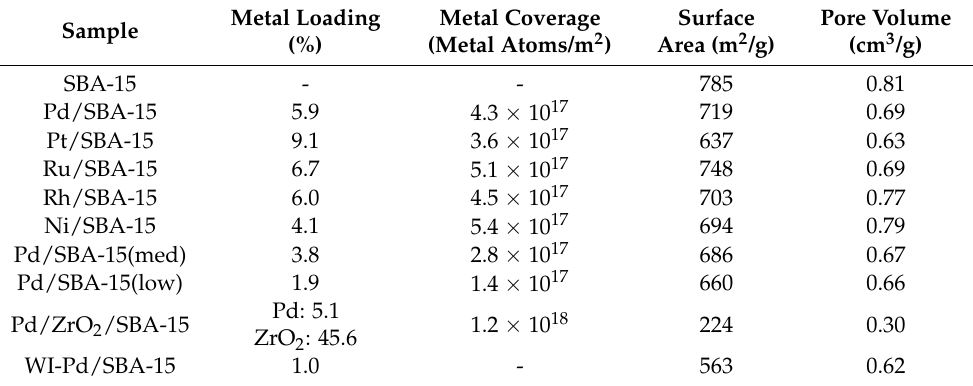
Table 1. Properties of SBA-15 and metal on SBA-15 synthesized by vapor-phase infiltration and